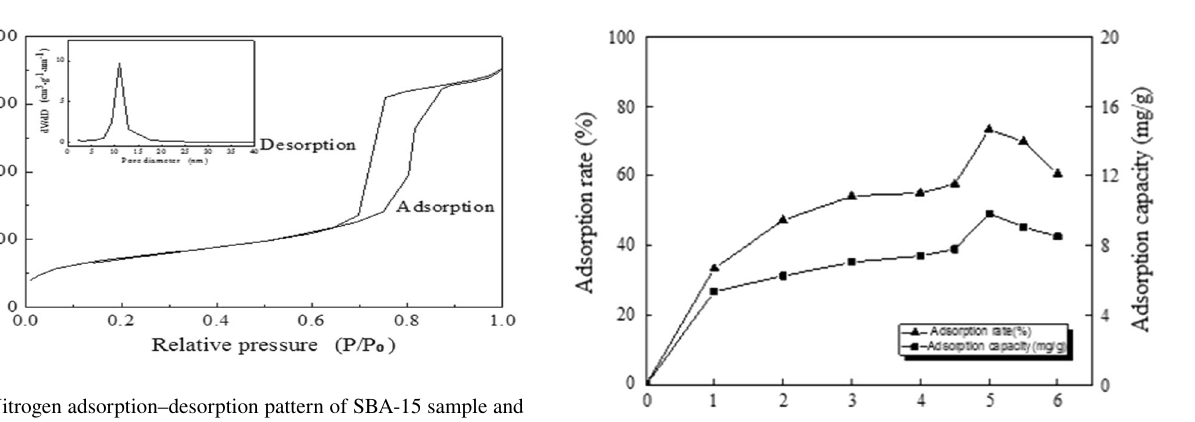
Fig. 4 Nitrogen adsorption–desorption pattern of SBA-15 sample and pore size distribution pattern